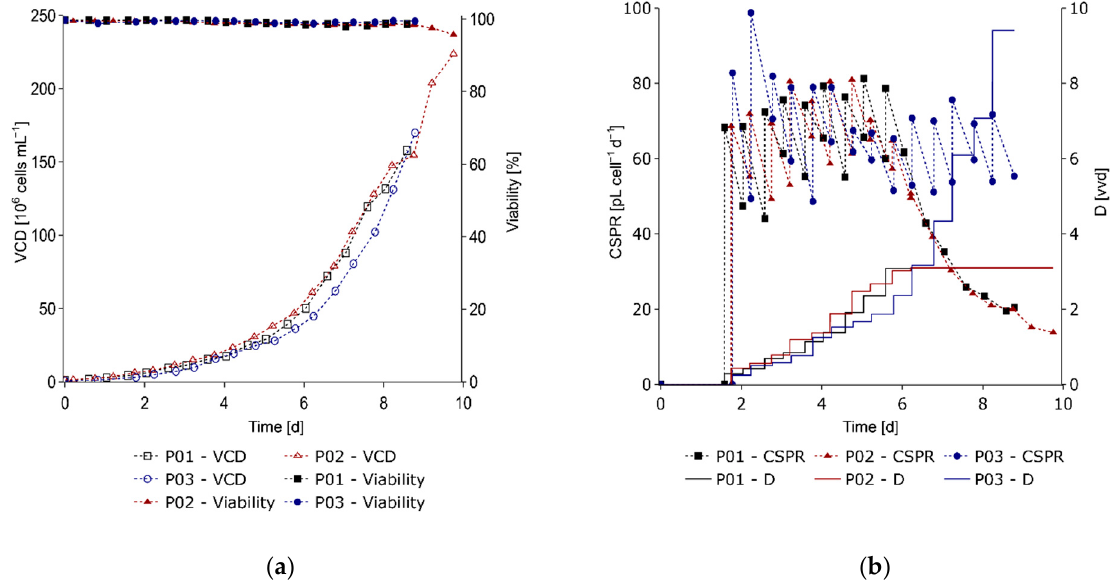
Figure 5. ( a ) Course of the VCD and viability of P01, P02, and P03, and ( b ) course of perfusion rate D and the CSPR of P01, P02, and P03.